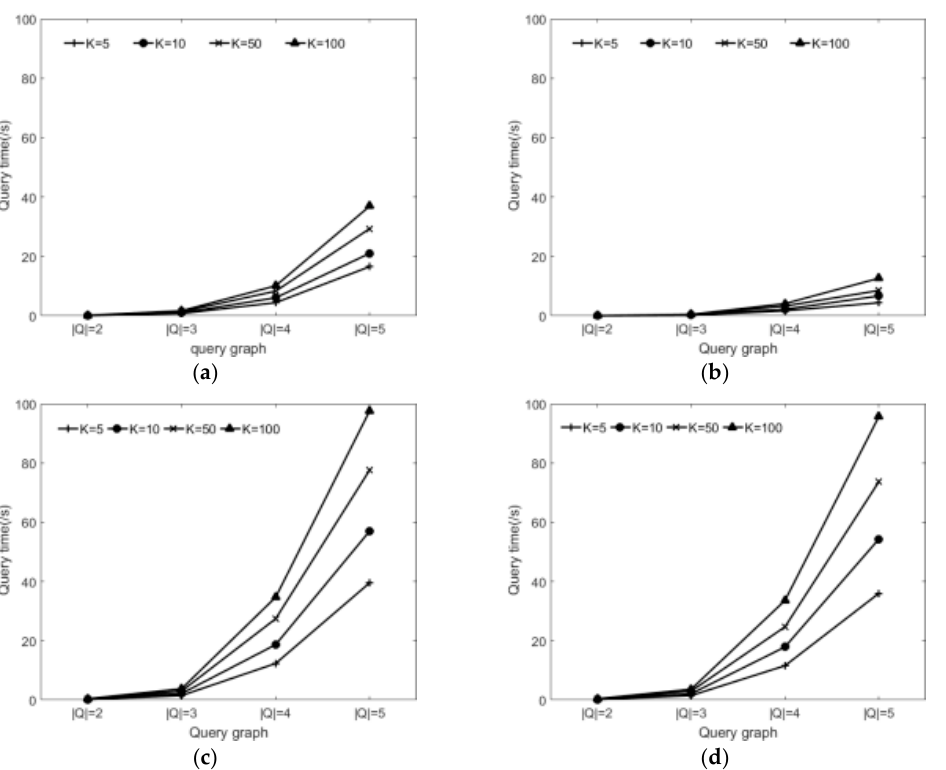
Figure 10. Effect of varying query graph and the K. ( a ) Comparisons in DBLP; ( b ) Comparisons in Wordnet; ( c ) Comparisons in Youtube ( d ) Comparisons in Dbpedia. Wordnet; ( c ) Comparisons in Youtube ( d ) Comparisons in